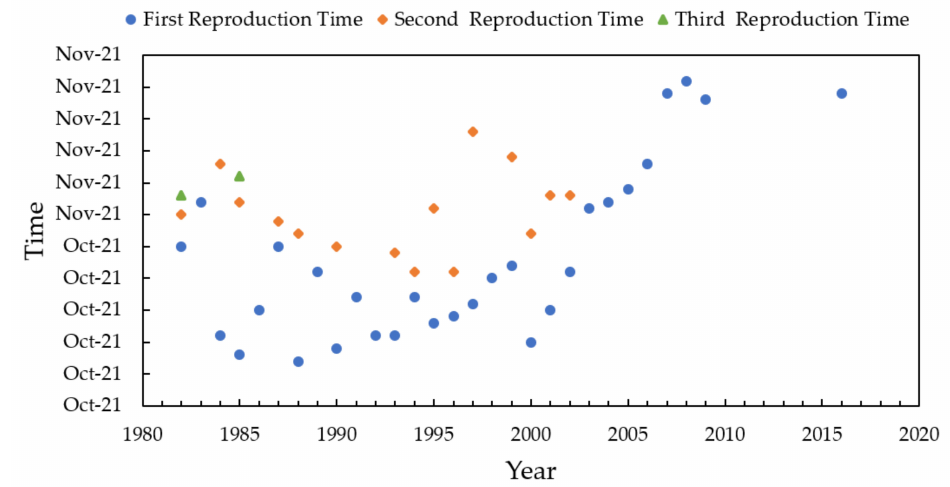
Figure 8. Variation of reproduction time of Chinese sturgeon in the Yangtze River.